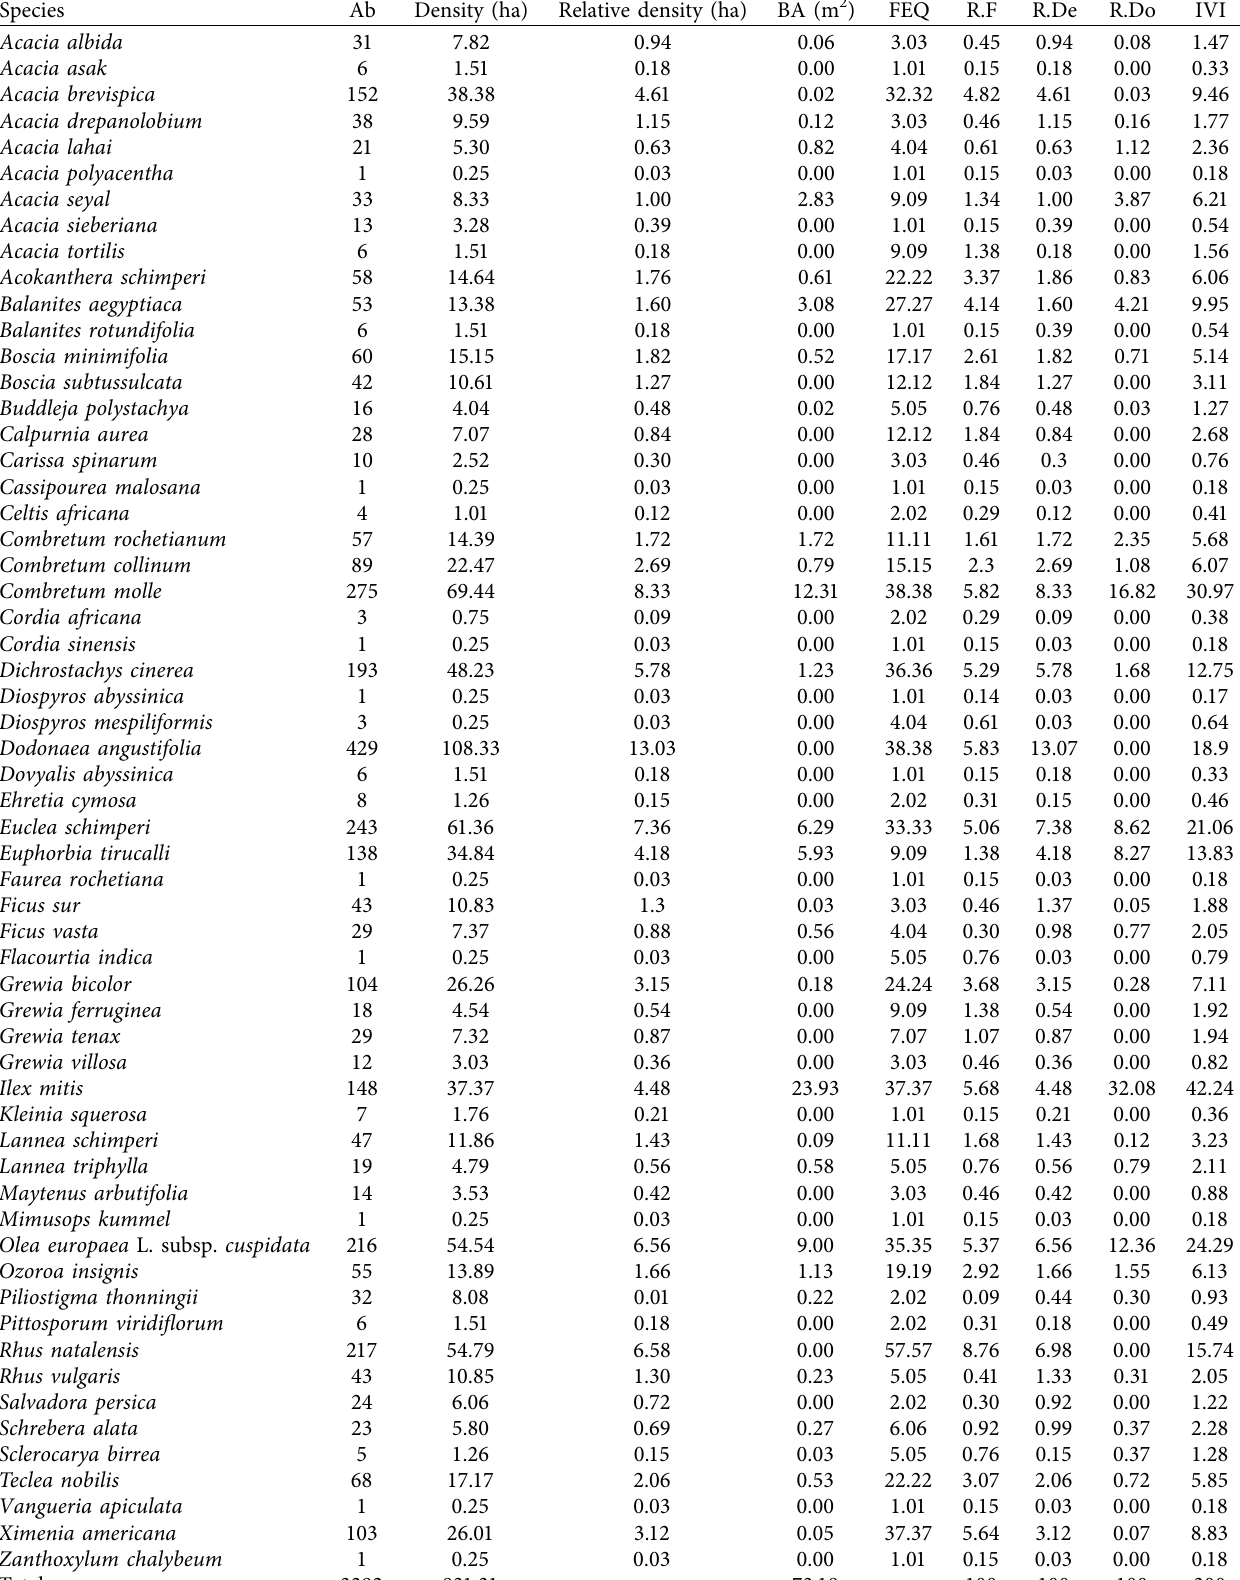
Table 2: Structural analysis of trees and shrubs in the study area (99 plots of 20m × 20 m (400 m 2 ) � (3.96 ha). Species